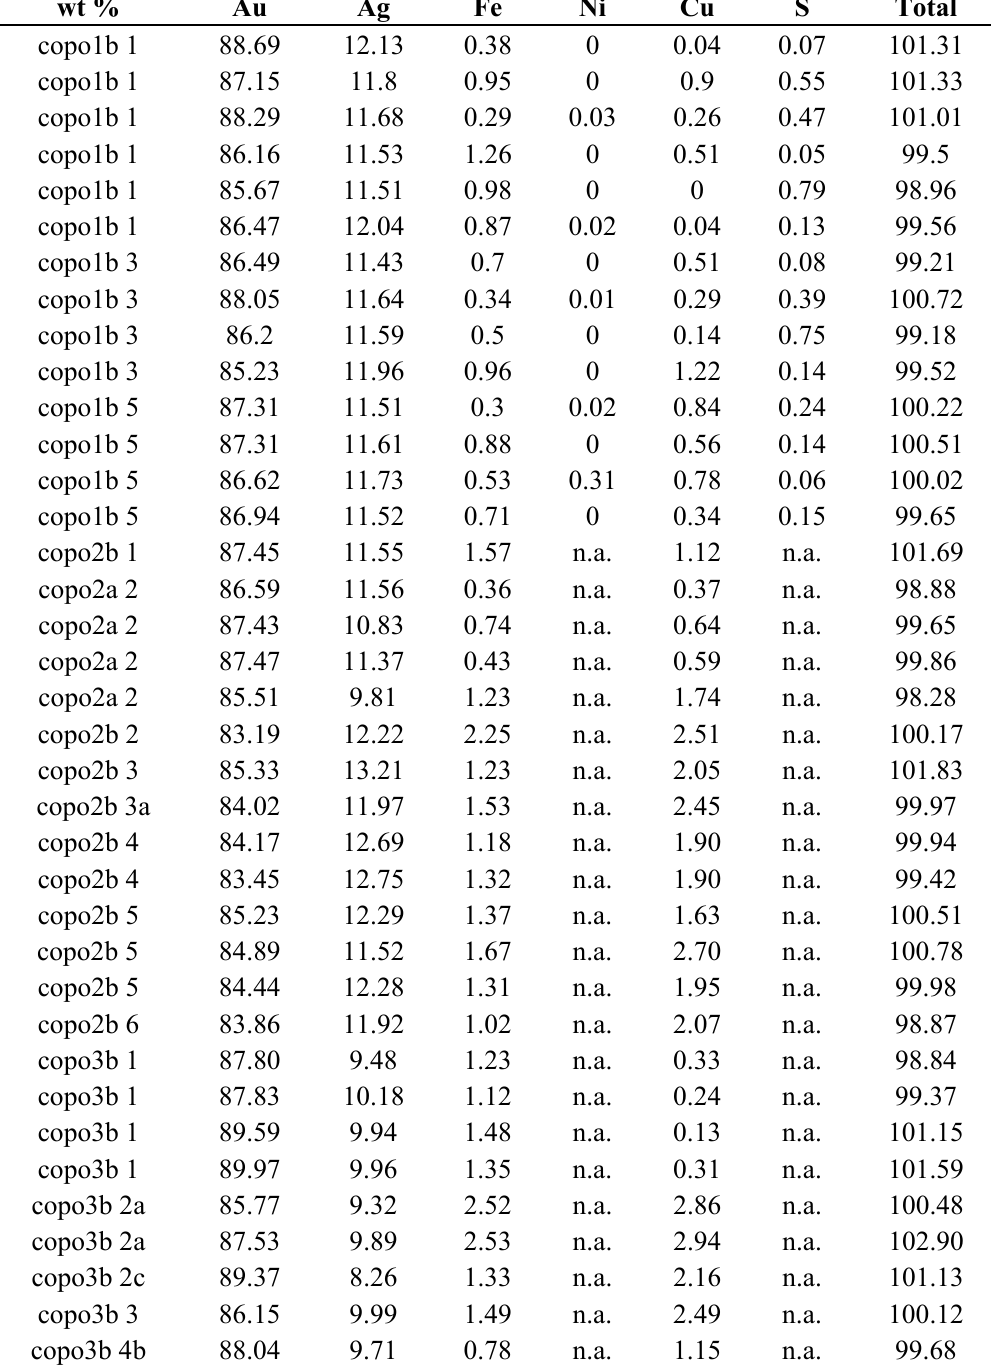
Table 3. Selected analyses of gold from the Pozzo